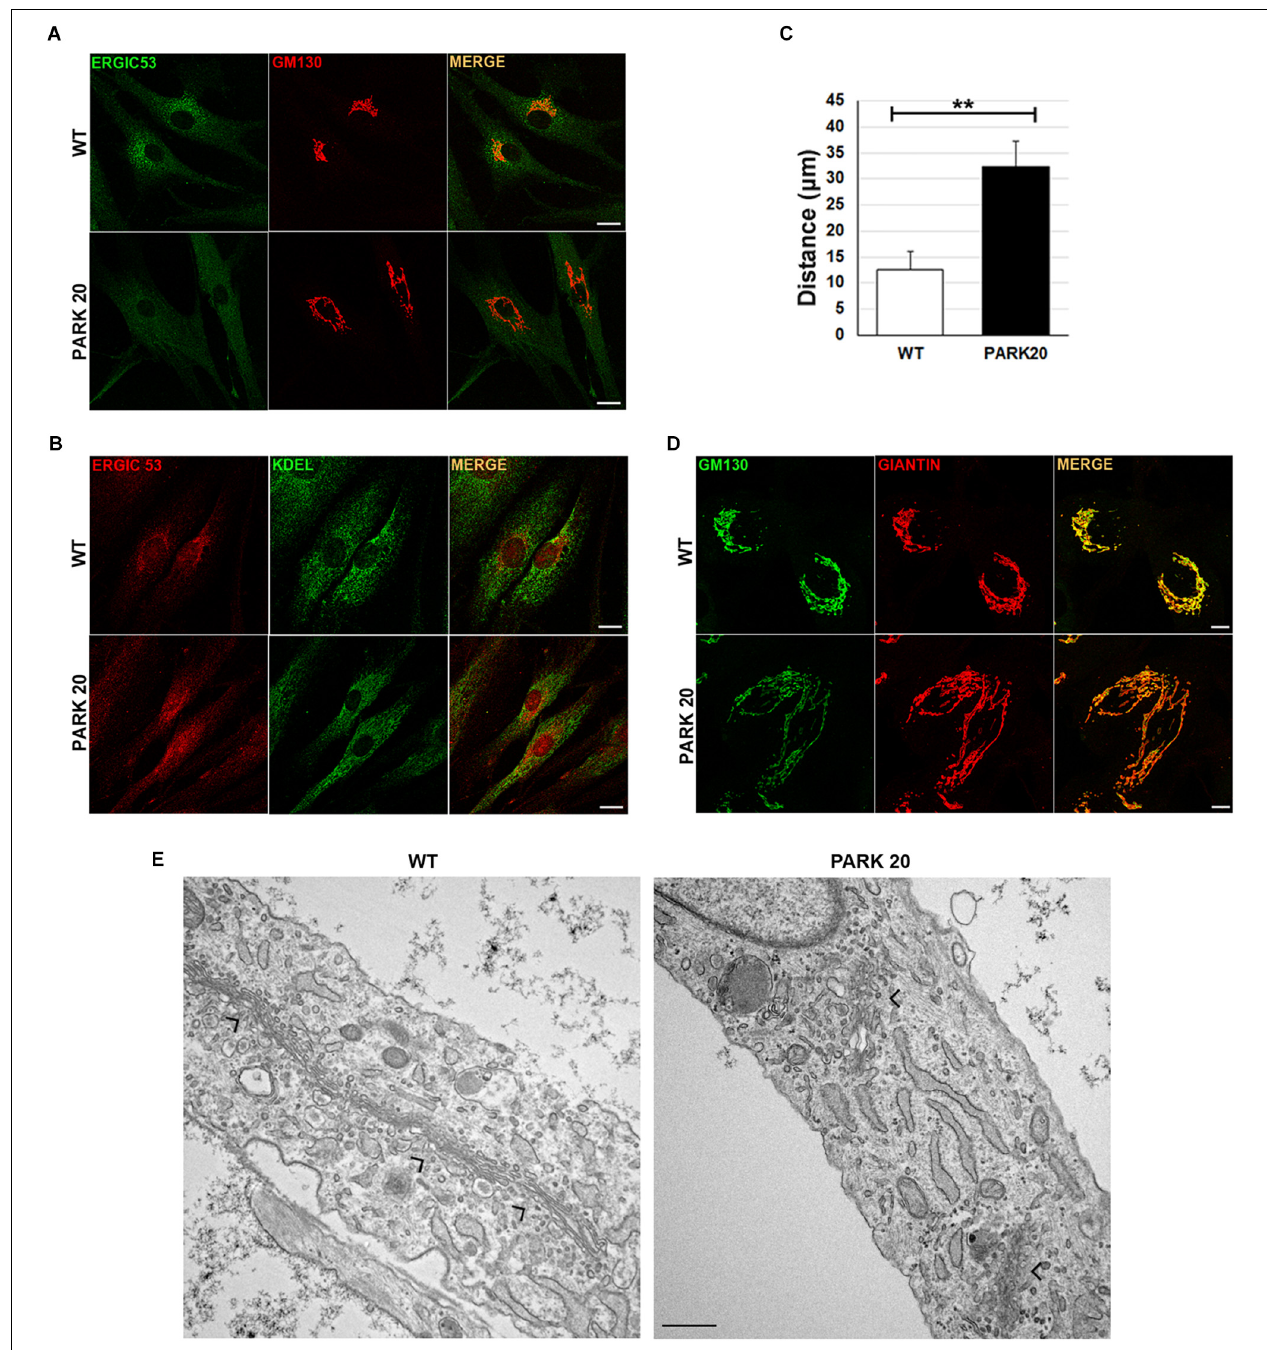
FIGURE 1 | Protein markers of the early secretory pathway are differently distributed in WT and PARK20 fibroblasts. (A,B,D) HDF (WT) and PARK20 cells were seeded on glass coverslips, fixed and processed for immunofluorescence with the indicated antibodies. Images were collected by confocal microscope. Scale bars: 10 µ m. (C) Histogram shows the distance (mean ± SD in µ M) from the nucleus of ERGIC-53 fluorescent spots. N ≥ 30. ∗∗ p ≤ 0.01, Student’s t -test. (E) Representative ultrastructural images of WT and PARK20 cells. Scale bar: 1 µ m; arrows indicate the position of Golgi complex.